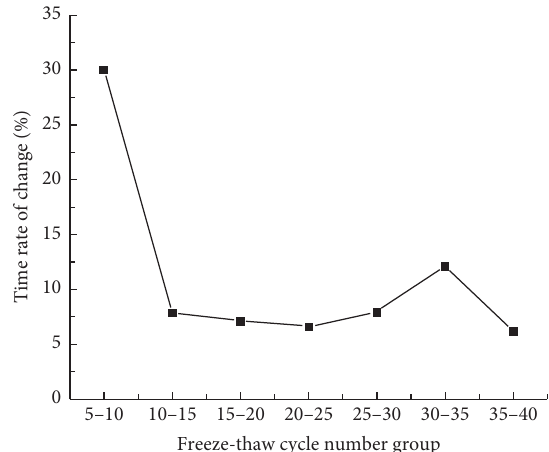
Figure 5: The change rate of the duration of the freezing process after every 5 freeze-thaw cycles.